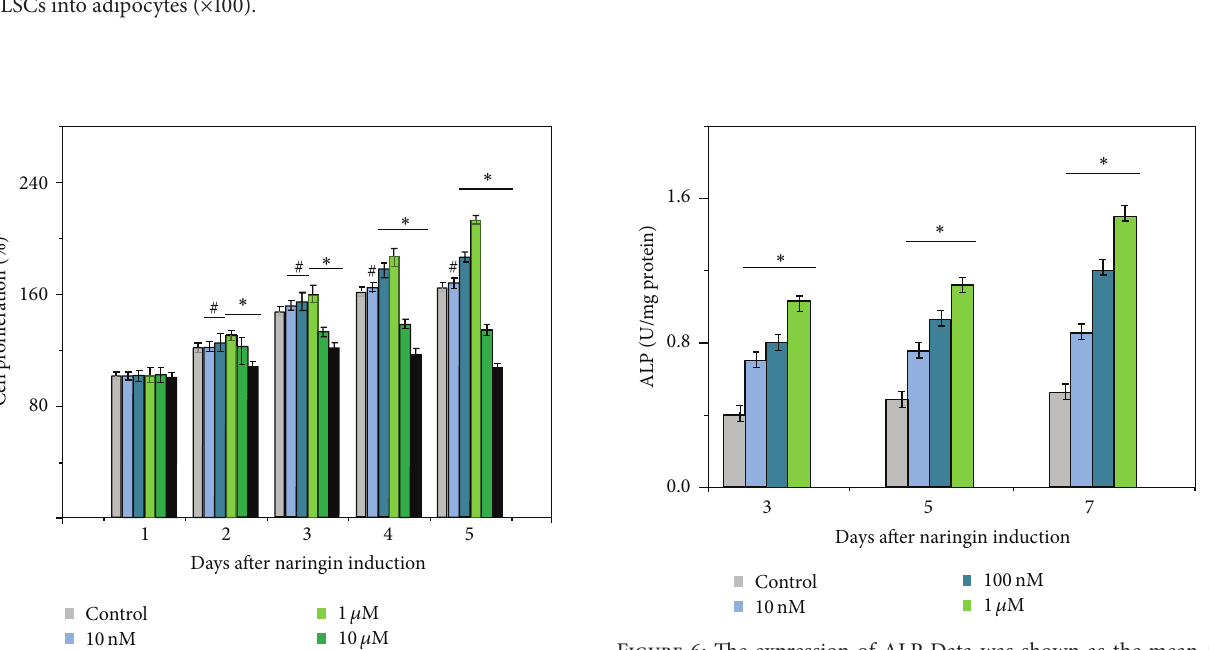
Figure 6: The expression of ALP Data was shown as the mean ± SD ( 𝑛 = 6 ). ∗ is compared with control group, 𝑃 < 0.05